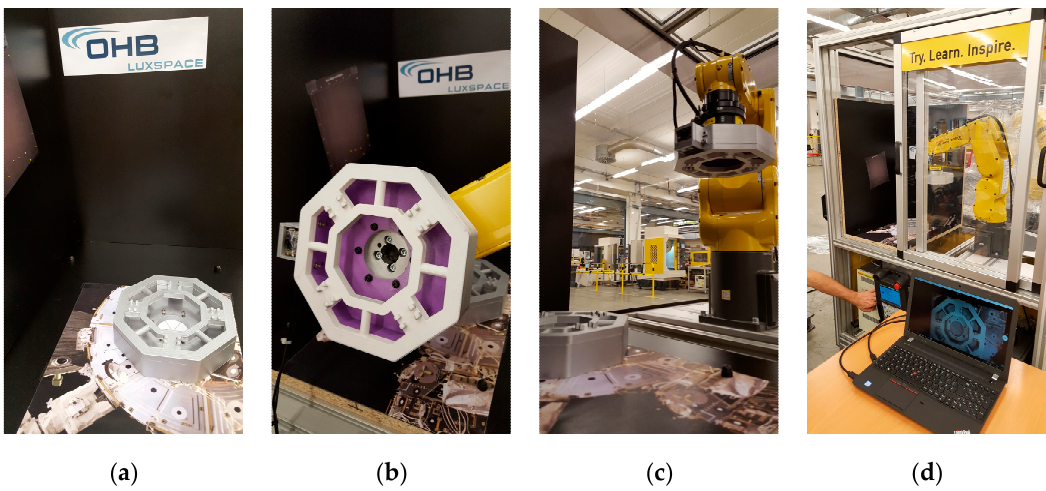
Figure 8. Final and complete test configuration used for the Automated Test on the 3rd Mechanism: ( a ) passive part of the prototype fixed on the test bench; ( b ) active part of the prototype (equipped with a “star tracker/docking” camera, visible on the left side) mounted on the robot via the force sensor; ( c ) a view of the principal elements of the test before sequence start ( d ) a view of the principal elements of the test during sequence—note on the laptop: the image taken simultaneously by the mounted “star tracker/docking” camera.